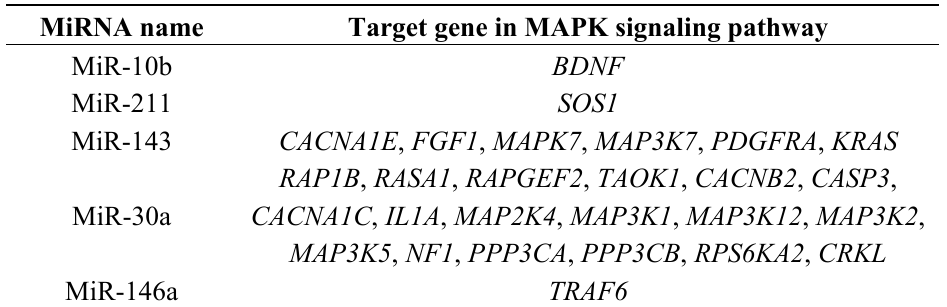
Table 5. Target gene of differentially expressed miRNAs in the MAPK signaling